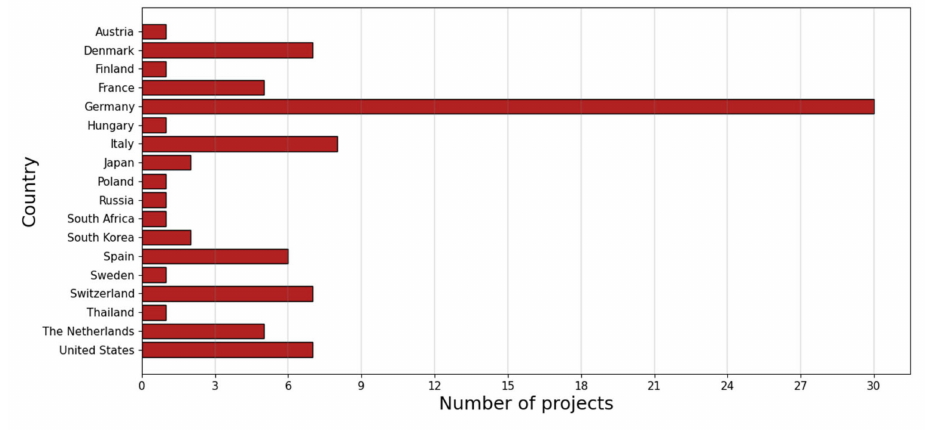
Figure 2. Power-to-gas projects grouped according to